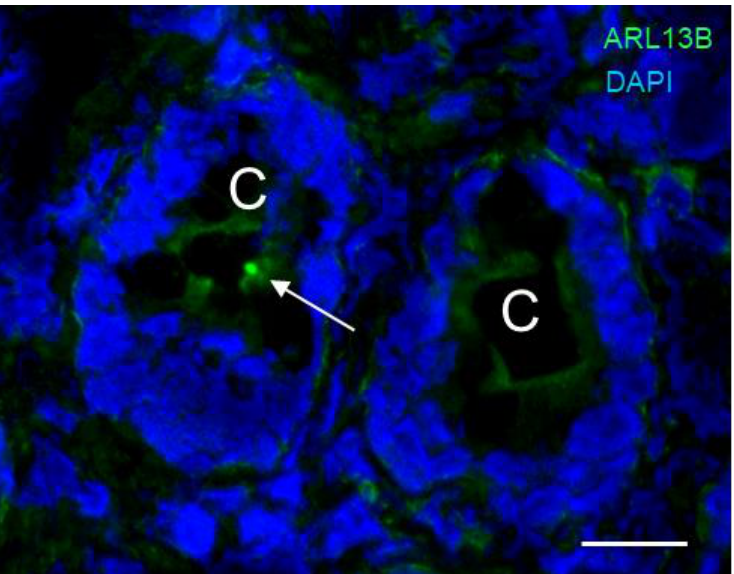
Figure 5. Primary cilia in the lower third of a crypt of the human small intestine. A, Representative immunodetection of primary cilia using the anti-ARL13b 90413h antibody (green staining) (arrow) in one of the crypts (C). Nuclei were stained with DAPI (blue staining). Scale bar is equal to 10 µm. As expected for polarized epithelial cells, the centrosomes were detected in the apical region of every cell while ARL13B stained with the 90413h antibody was generally detected under a single instance in the few crypts identified as being positive (Figure 6A,